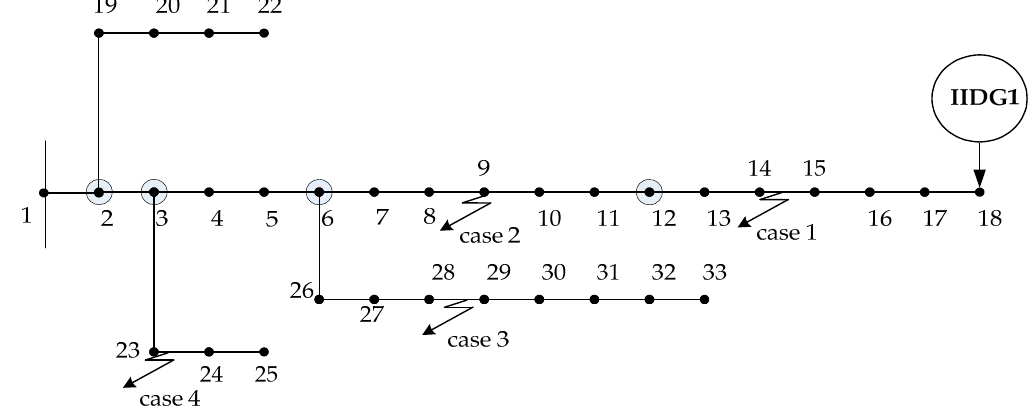
Figure 5. Modified IEEE 33 node distribution benchmark.